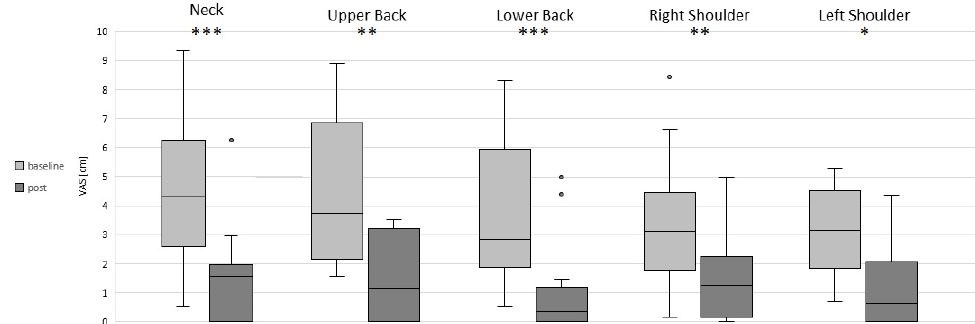
Figure 2. Pain intensity at baseline and post-intervention in the neck, upper back, lower back and right and left shoulders. Significant differences are marked with asterisks: * p < 0.05, ** p < 0.01 and *** p < 0.001. Table 2. Descriptive data of the pain intensity at baseline and post-intervention in the neck, upper back, lower back and right and left shoulders.